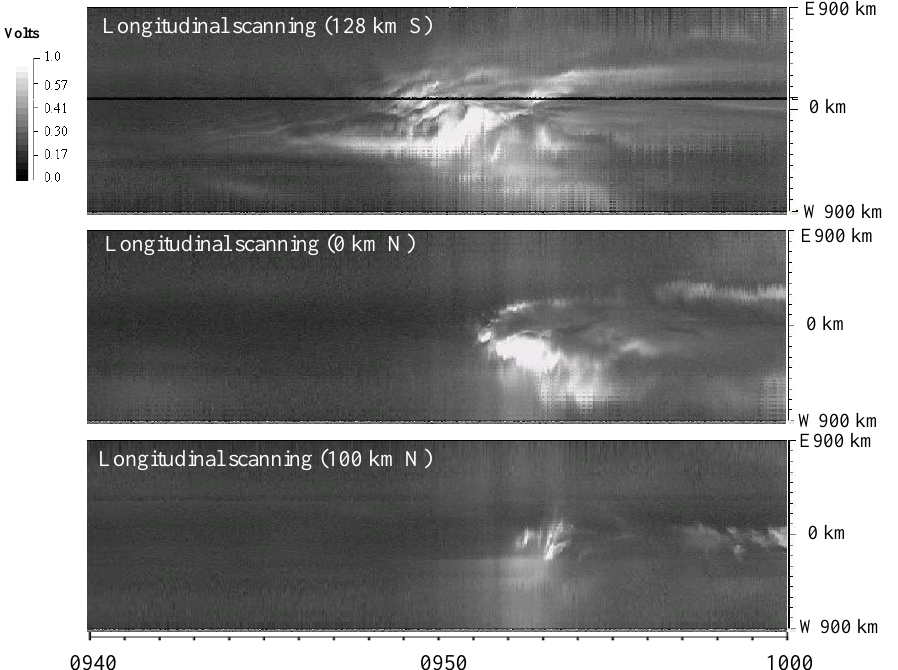
Figure 2. Longitudinal scanning of aurora along three different latitudes, 128km south of DWS (128km S), above DWS (0km N), and 100km north of DWS (100km N) for the 20min intervals from 09:40UT to 10:00UT. The longitudinal scanning is 1800km from 900km west of DWS and to 900km east of DWS. The aurora gray level is plotted to the